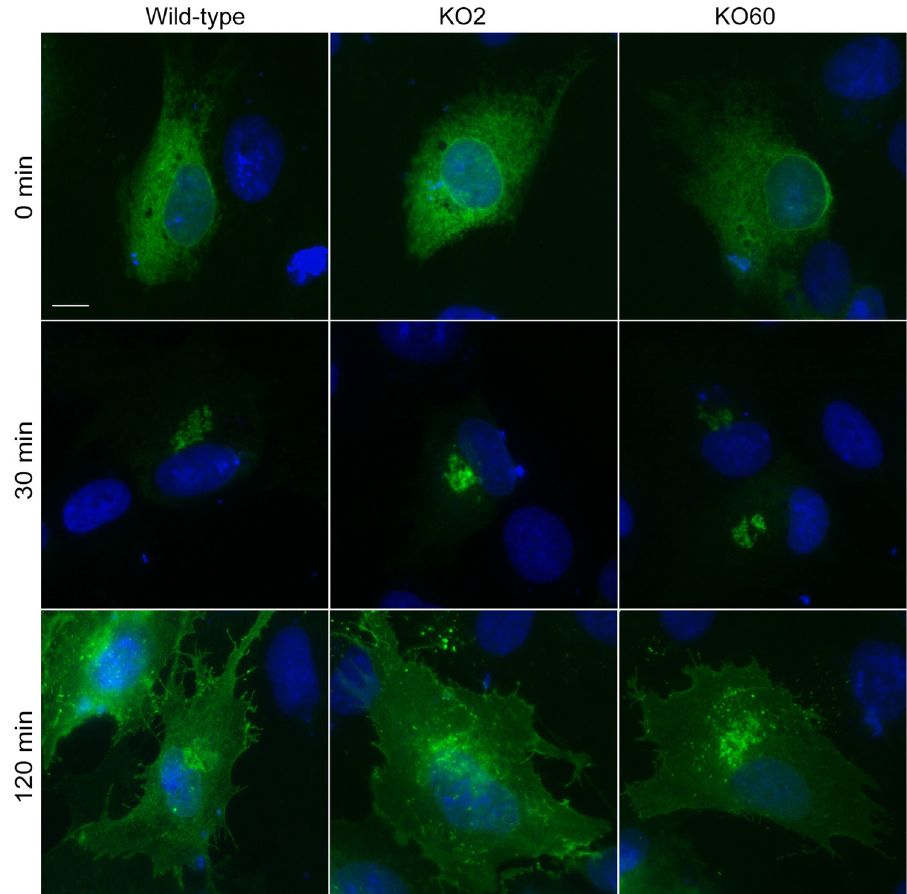
Fig 5. GM130 does not function in protein transport. Wild-type and GM130 KO cells were transfected with tsO45-VSV-G-GFP. 18 hours post transfection, cells were transferred to 42˚C for 5 hours to allow VSV-G accumulation in the ER (top panel), followed by a shift to the permissive temperature of 32˚C. Cells were fixed after 0 min (top panel), 30 min (middle panel) and 120 min (bottom panel) post transfer. Scale 10 μ m. Representative immunofluorescence images for each time point are shown, with the GFP signal revealing the localization of the VSV-G protein.